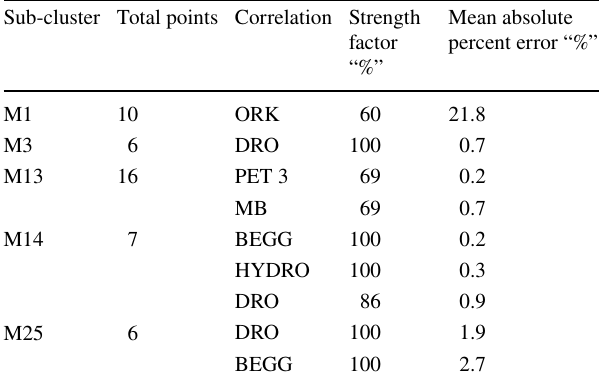
Table 21 Best correlations for cluster (M) Sub-cluster Total points Correlation Strength